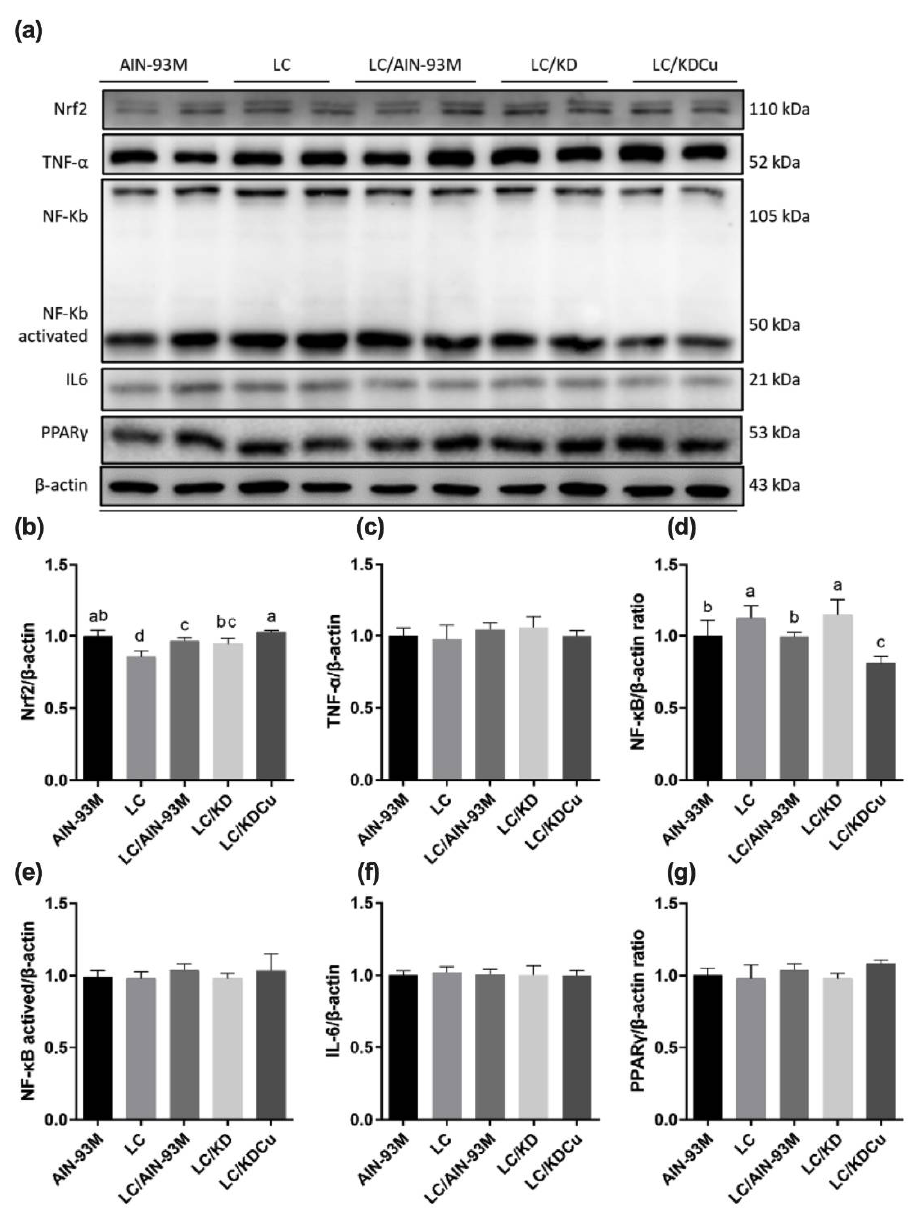
Figure 10. Effects of the low carbohydrate diet and curcumin on ( a ) protein expressions in each group, ( b ) Nrf2, ( c ) TNF- α , ( d ) NF- κ B, ( e ) NF- κ Bactived, ( f ) IL-6, ( g ) PPAR γ in male mice. Data are expressed as means ± SD. n = 6–9 per group. Bars (a, b, c, d) with different letters indicate that values are significantly different. (One-way ANOVA, Duncan’s test, p < 0.05). AIN-93M: AIN-93M diet; LC: